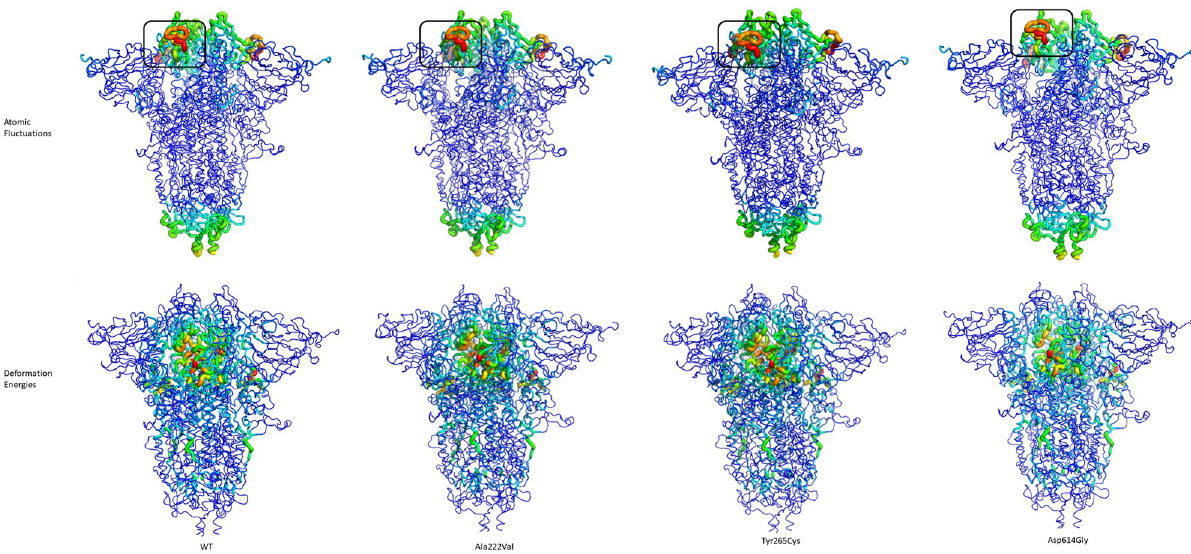
Fig 9. Enhanced normal mode analysis of the trimeric spike protein along the 20 ns MD simulation. WT, reference trimeric spike protein, A222V mutant, Y265C mutant, and D614G mutant. The top cyan row shows the atomic fluctuations, bottom row indicates deformation energies. Black box: residues 474–488 from RBD. The red color indicates higher